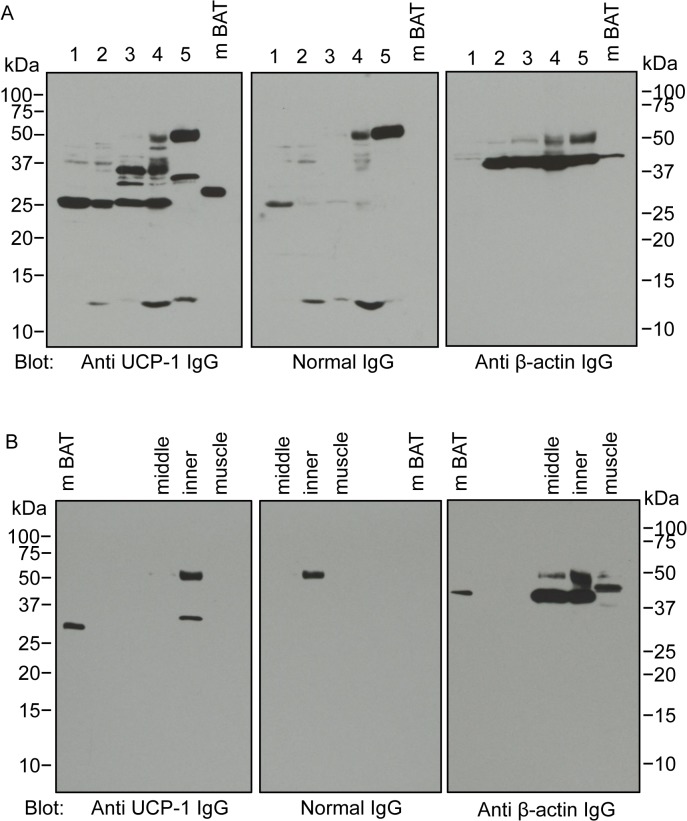
Western blot analysis of lowest layer of delphinoid blubber.Tissue extracts subjected to SDS-PAGE immunoblotting analysis using anti-UCP1, normal IgG or β-actin antibodies. (A) The blots of inner blubber layer extracts from cetaceans. 1, EL-13137; 2, UMUT-14006; 3, SNH13005-1; 4, SNH13005-2; 5, UMUT-12343. (B) The blots of middle, inner blubber layer and muscle extracts from UMUT-12343. Mouse BAT extracts were loaded as a positive control (mBAT). Data are representative of three separate experiments. Protein migration indicated by bars to the left and right of the figure.